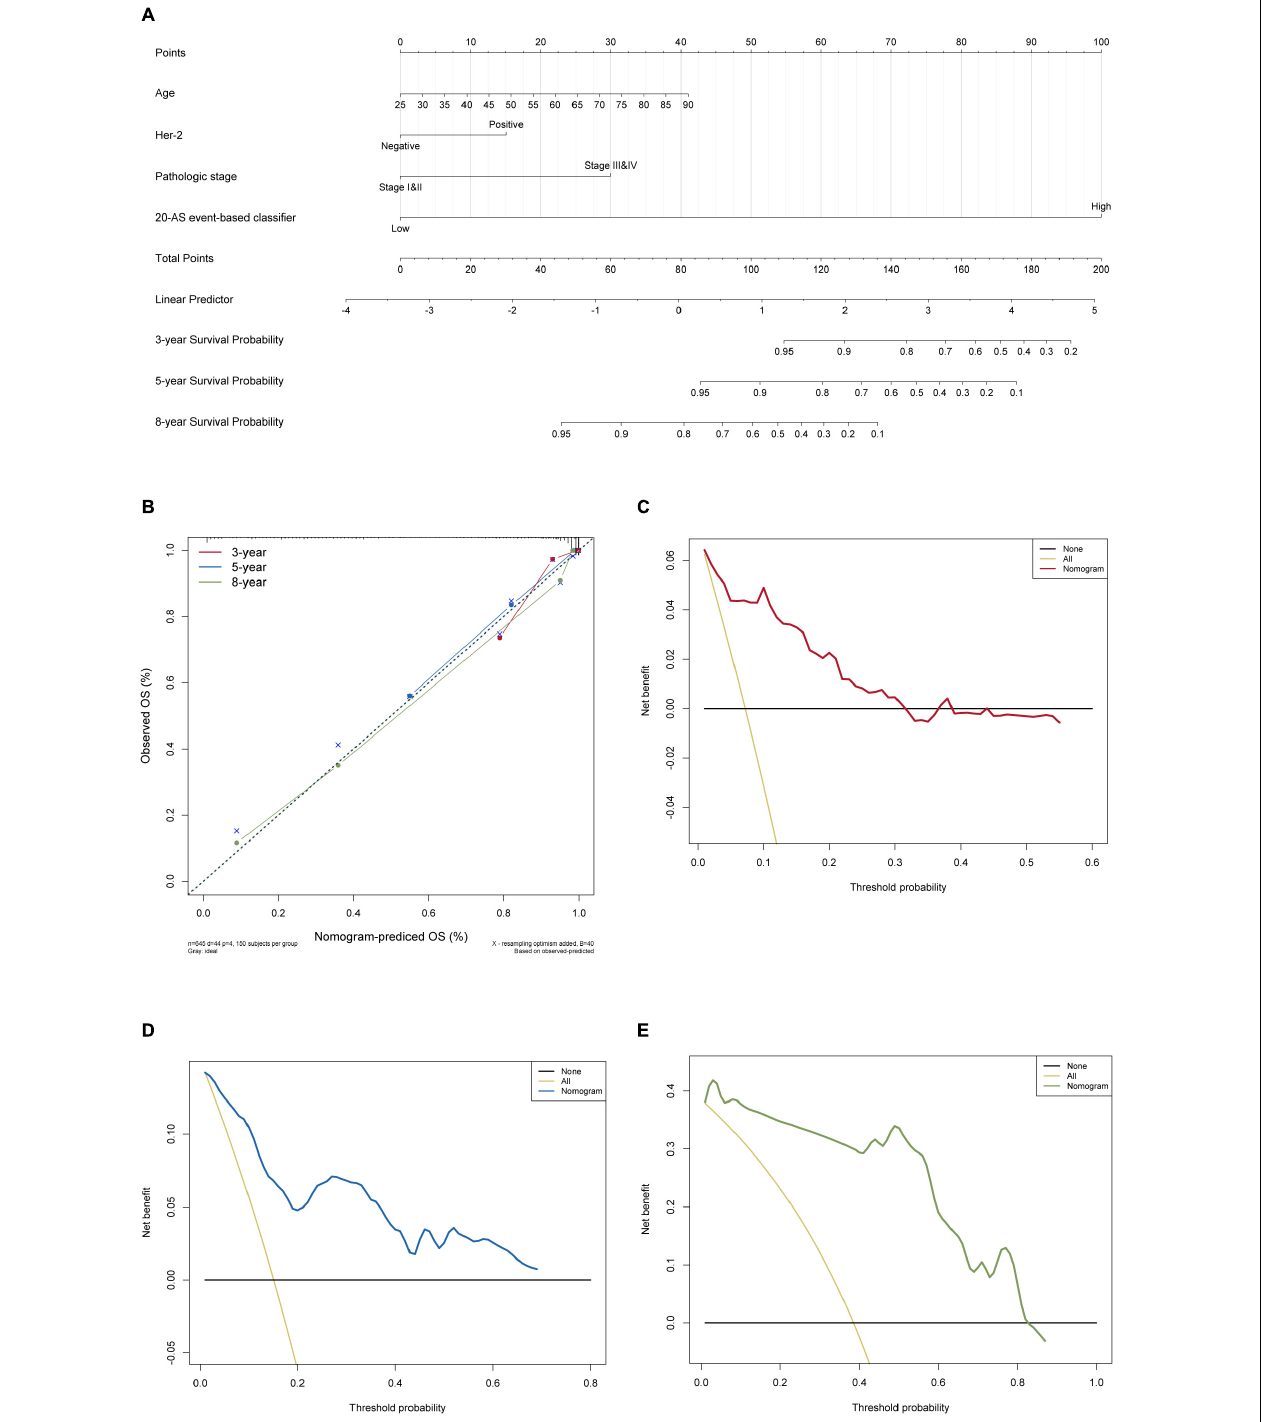
FIGURE 8 | The AS-clinicopathologic nomogram for prediction on survival probability in patients with BRCA. (A) Development of AS-clinicopathologic nomogram for predicting 3-, 5-, and 8-years OS for BRCA patients, with the final AS signature, age, pathological stage and Her-2 status incorporated. (B) Calibration plot of the AS-clinicopathologic nomogram in terms of agreement between nomogram-predicted and observed 3-, 5-, and 8-years outcomes in BRCA cohort. The actual performances of our model are shown by red, blue and green lines. And the dashed line of 45 ◦ represents the ideal performance. (C–E) Decision curve analyses of the AS-clinicopathologic nomogram for 3-, 5-, and 8-years risk in BRCA cohort. The yellow line represents the net benefit of treat-all scheme varying with threshold probability, while the black line represents the net benefit of treat-no scheme. The net benefits by using our nomogram for predicting 3-, 5-, and 8-years OS are displayed with red, blue, and green lines,